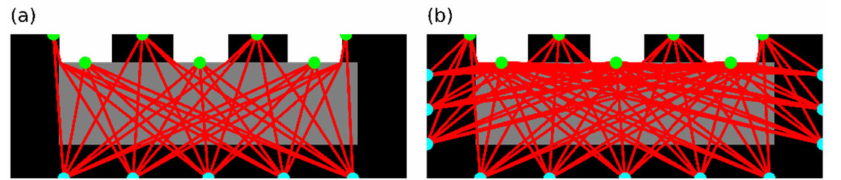
Figure 2. Pathways defining beams in 2D toy examples ( a ) S1 configuration, and ( b ) S2 configuration. Emitters are represented by a green dot, while receivers are blue. The gray zone defines the limits for the region referred to as the central region in the anode